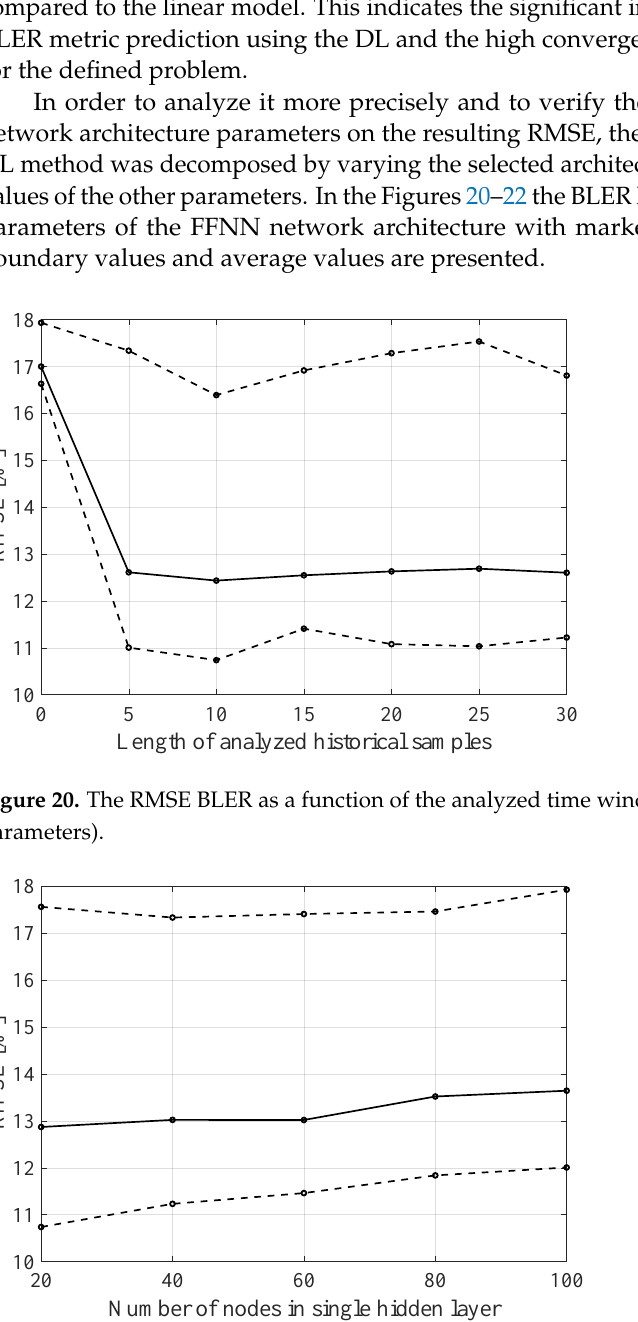
Figure 21. The RMSE BLER as a function of the node number in the hidden